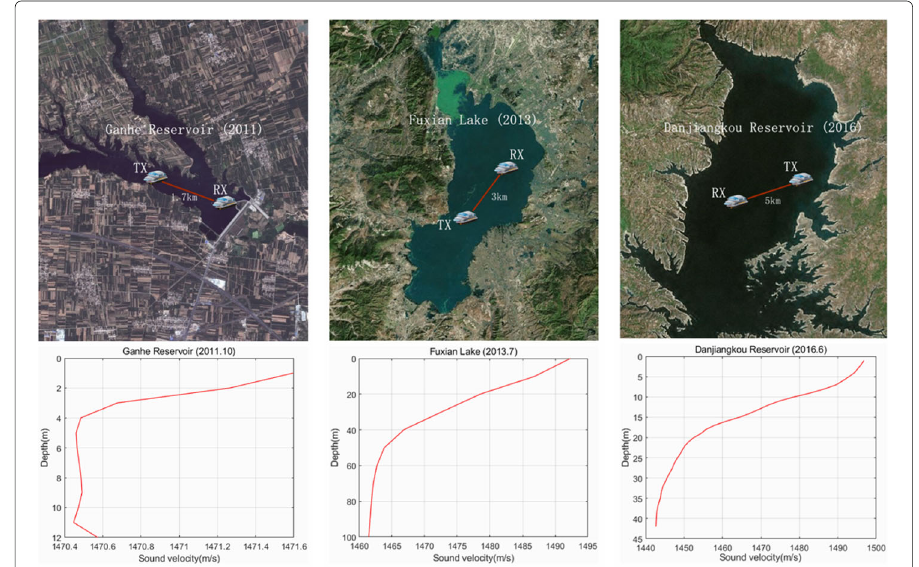
Fig. 9 Configuration of lake